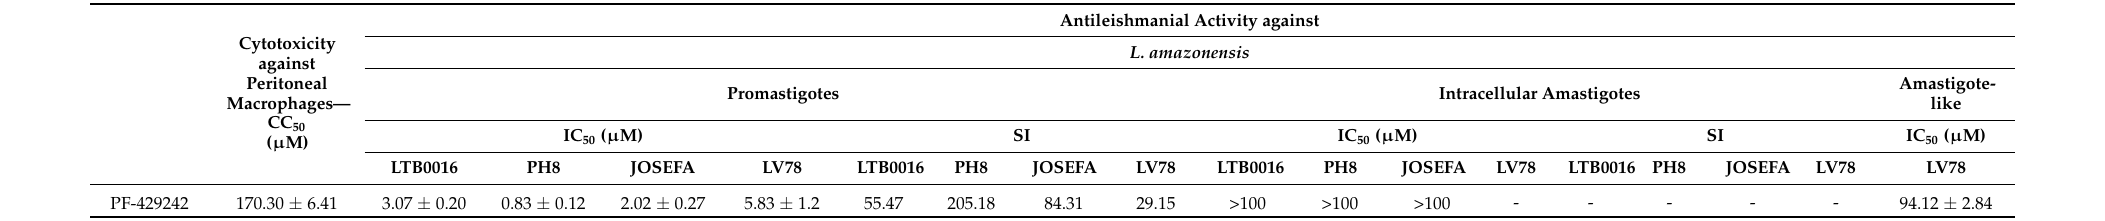
Table 2. Effect of PF-429242 against peritoneal macrophages and promastigotes and intracellular amastigotes of L. amazonensis